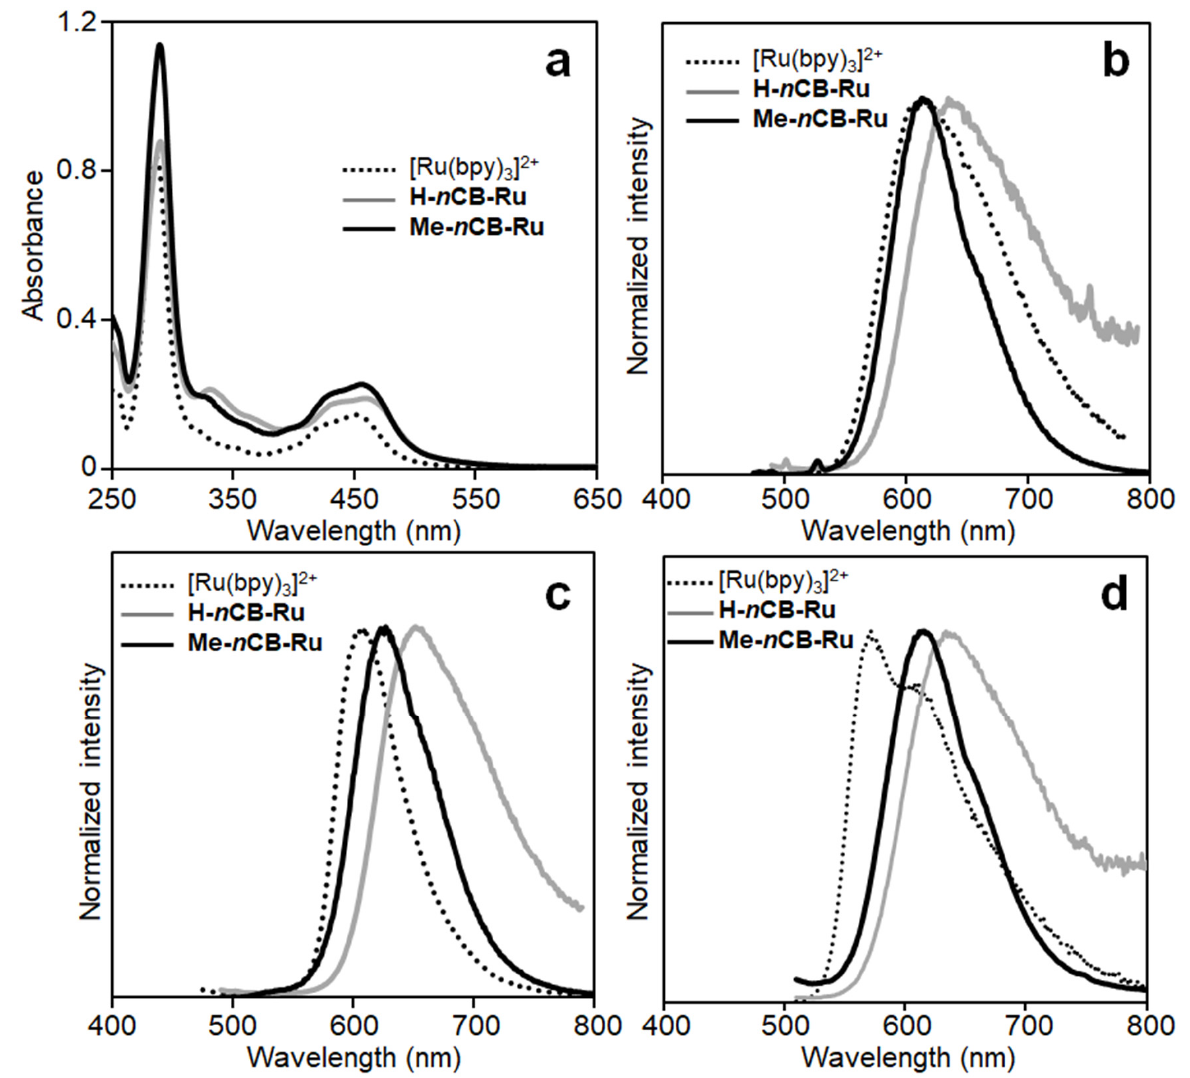
Figure 2. ( a ) UV–vis absorption and ( b ) phosphorescence spectra of the ruthenium complexes in EtOH/MeOH = 4/1 (1.0 × 10 –5 M), ( c ) solid and ( d ) 1 wt% PEG films.